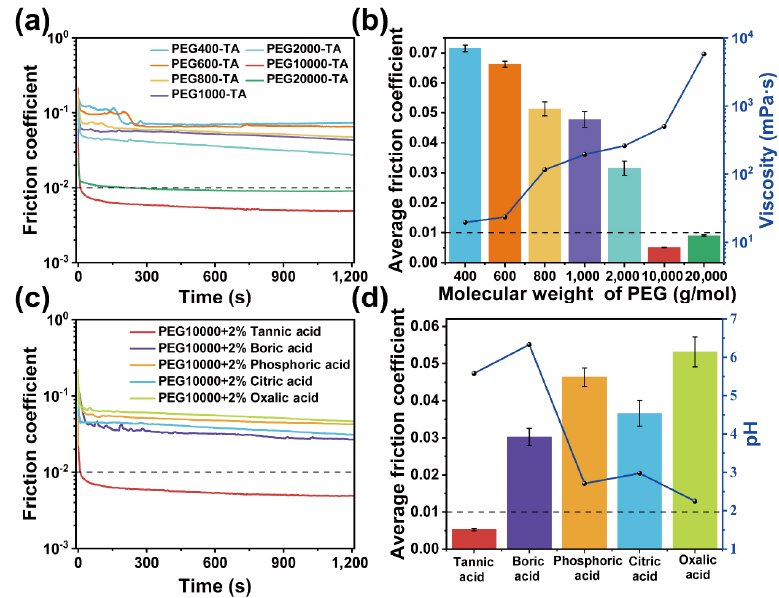
Fig. 6 (a) Friction coefficient–time curve and (b) average friction coefficient for mixed solutions of TA and PEG with different molecular weights (400, 600, 800, 1000, 2000, 10,000, and 20,000). (c) Friction coefficient–time curve and (d) average friction coefficient and pH value of different acid and PEG10000 mixed solutions. The load applied was 4 N, and the maximum linear sliding speed was 0.025 m/s. The mass fractions of PEG with different molecular weights and different types of acids in the lubricant were 45 wt% and 2 wt%,